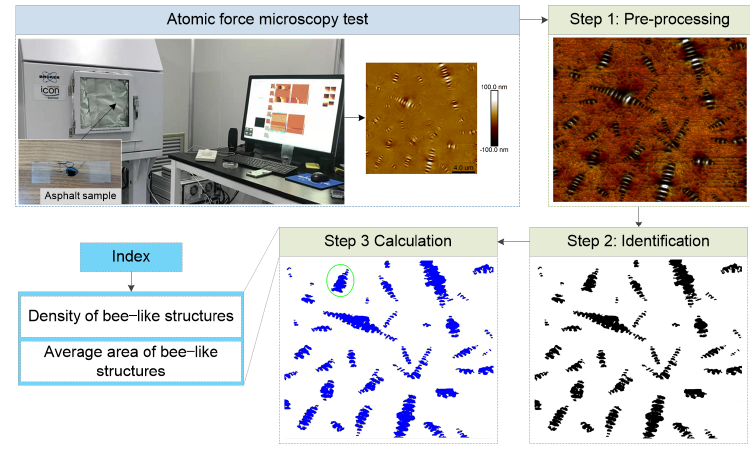
Figure 5. The analysis process for the asphalt micro-morphologic image.